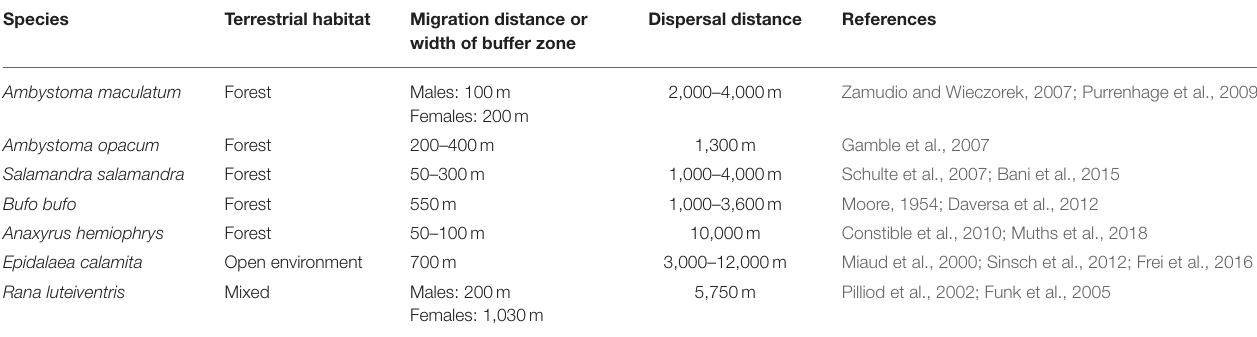
TABLE 1 | Some examples of the distance differences between migration (intrapopulation round-trip movements to and away from breeding sites) and dispersal (inter-population one-way movements from a birthplace to a breeding site) in selected amphibians.